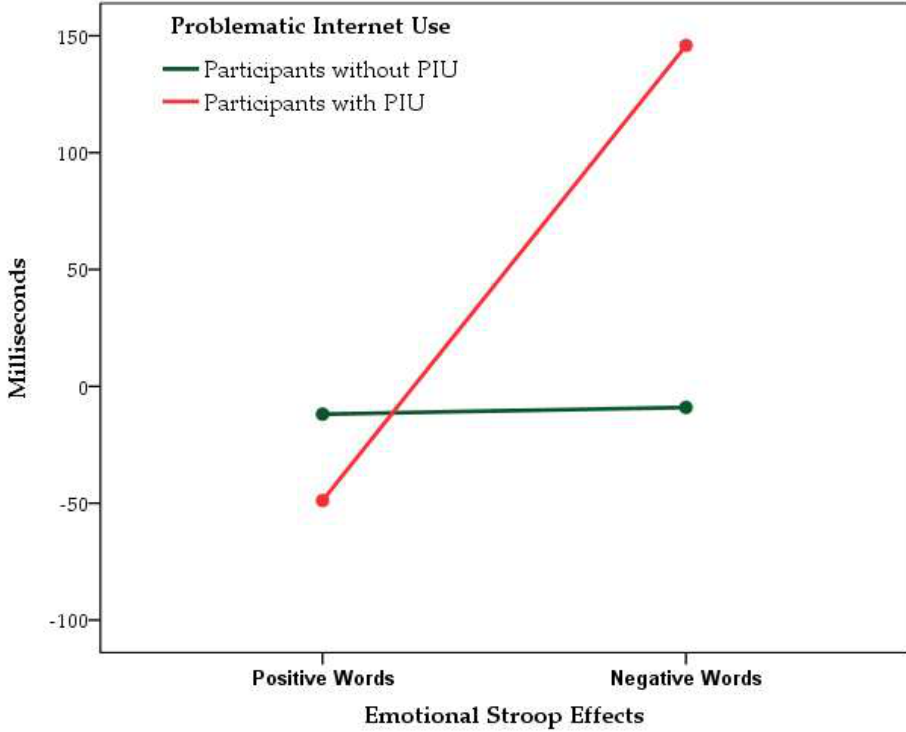
Figure 1. Estimated marginal means for emotional Stroop effects. Note: problematic Internet use = Internet addiction test score of 50 or above. Covariates appearing in the model are evaluated at the following values: age (in years) = 24.41, education (in years) = 13.55, PANAS-Positive States scale = 36.23, PANAS-Negative States scale = 17.17, colored words (in milliseconds) = 1170.55.